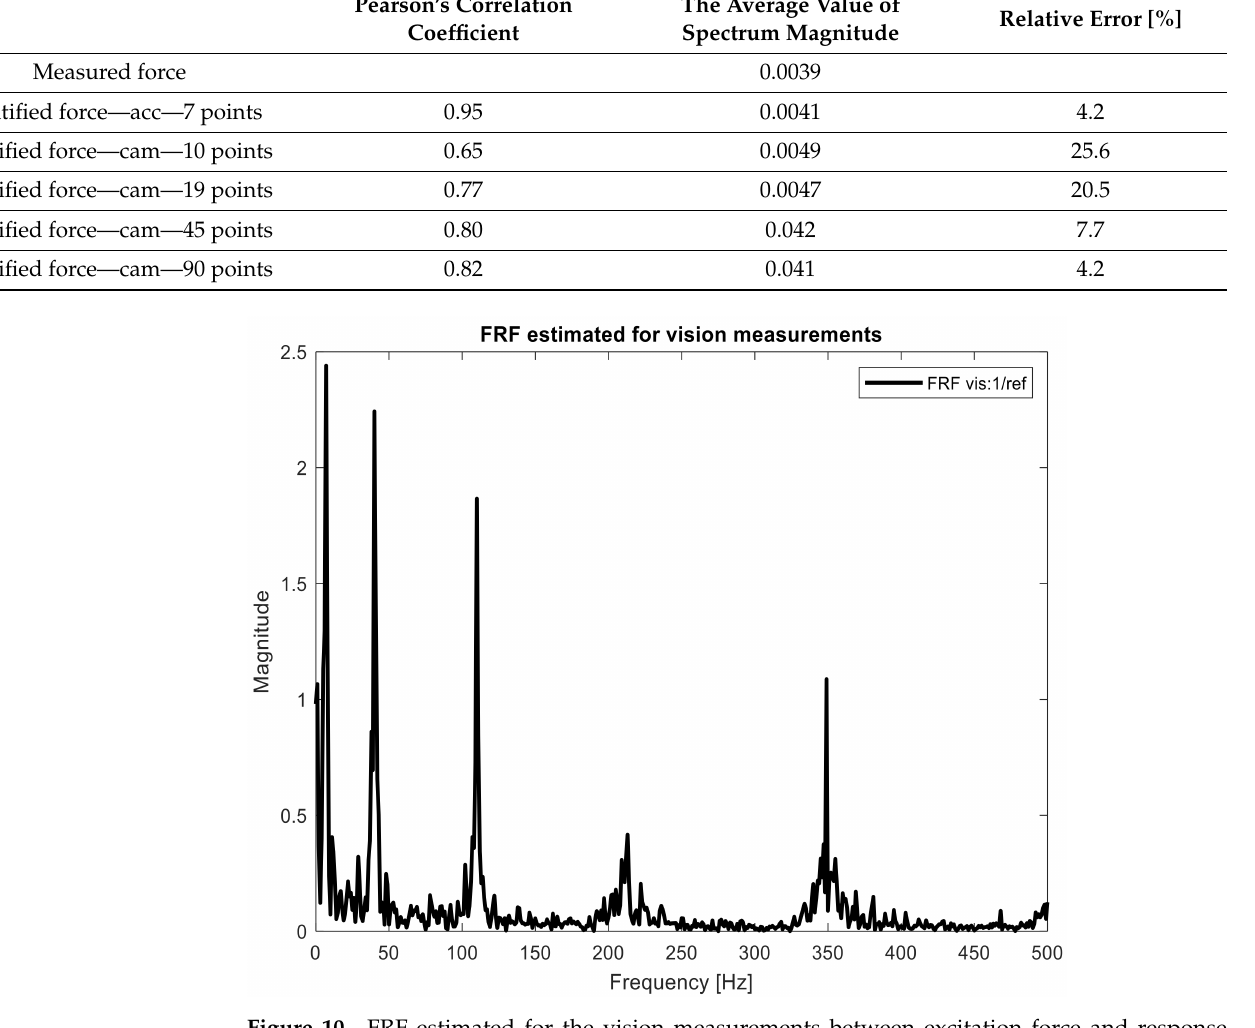
Figure 10. FRF estimated for the vision measurements between excitation force and response measured in point vis:1 (the first marker on the left side of the